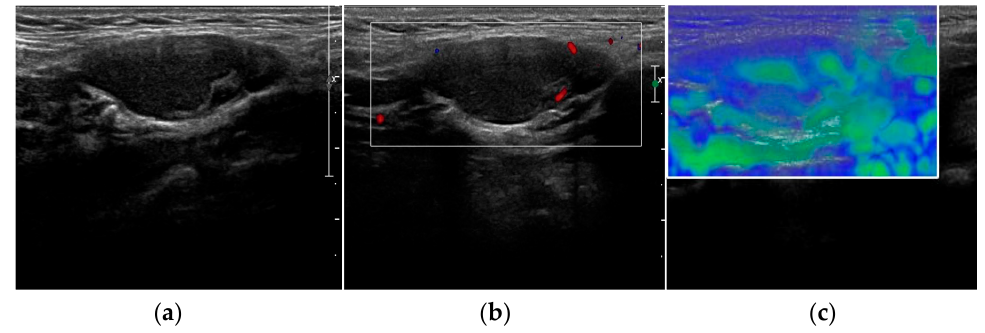
Figure 5. Grey-scale ( a ), Color Doppler ( b ) and elastography ( c ) aspect of a infected second branchial cleft cyst.